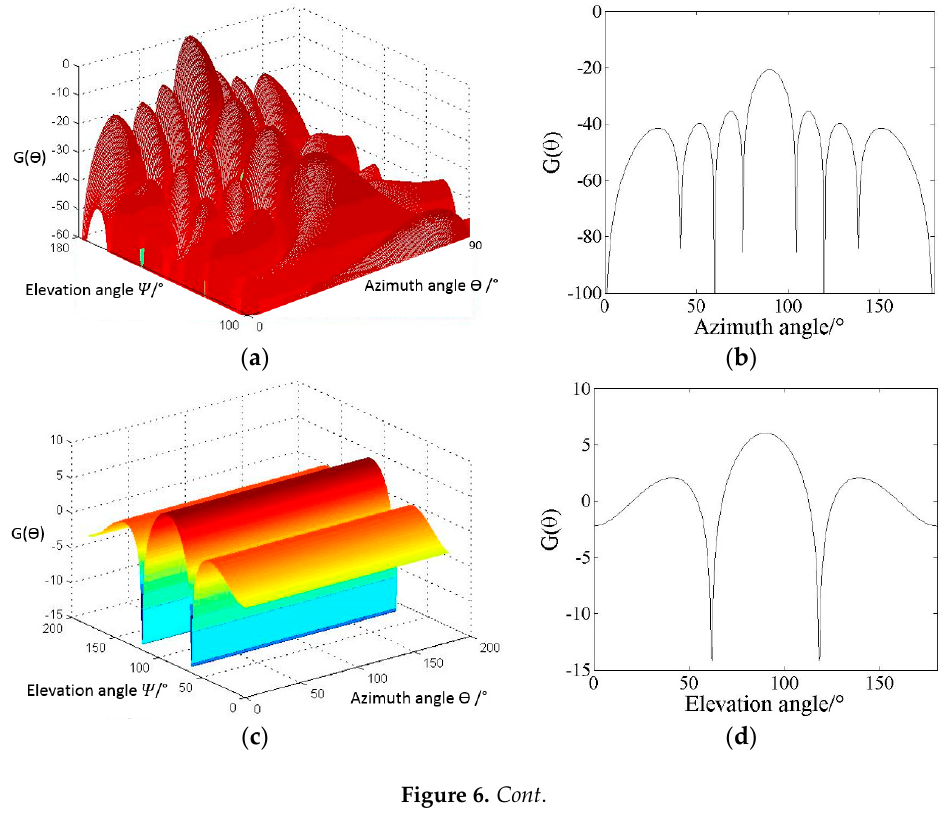
Figure 5. Double-helix-ultrasonic-array.